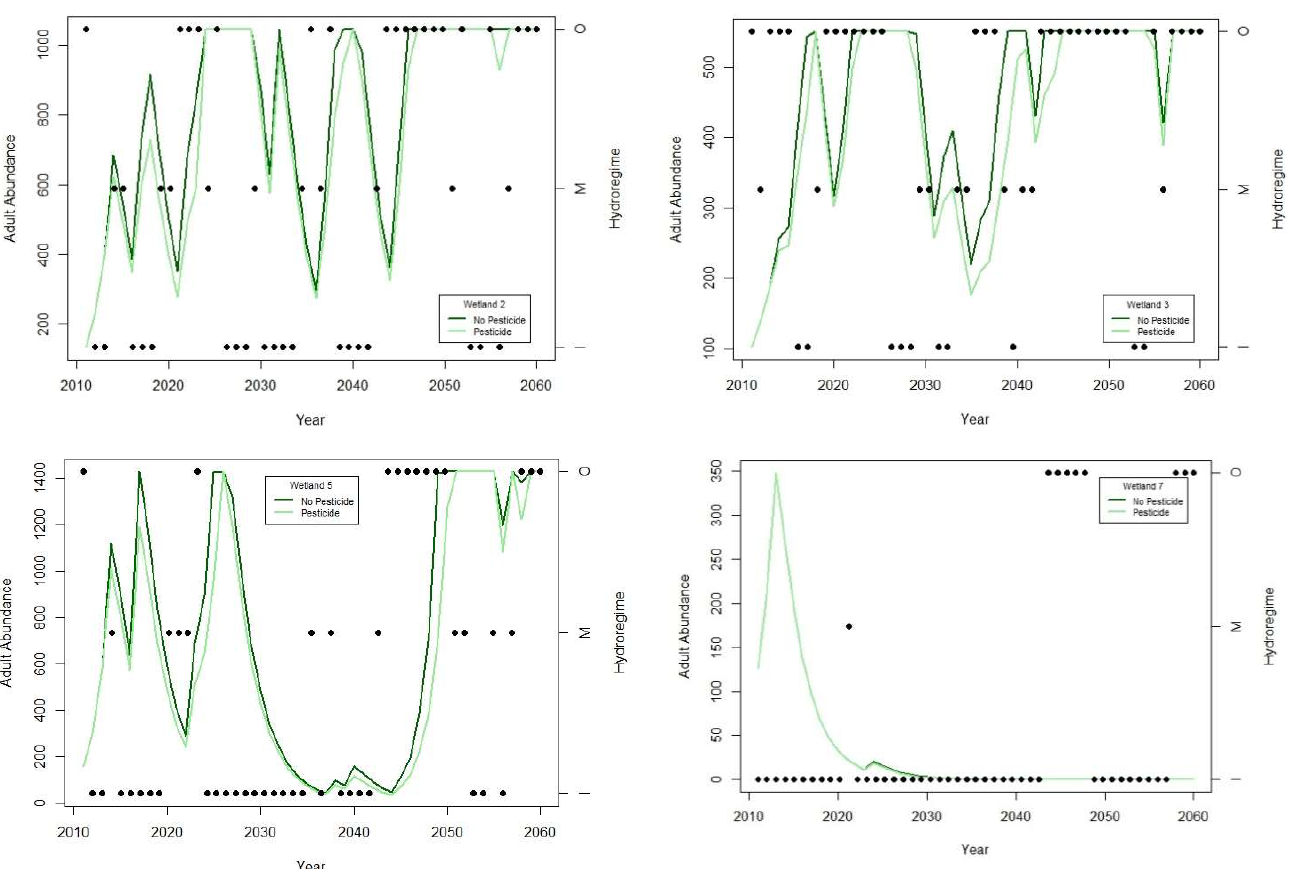
Figure 2. Estimated relative abundance of adults in southern toad populations, with standardized representative assumptions of density-dependent population limitation, for four patterns of hydroregime projections based on CSIRO Mk3.5 GCM climate projections at wetlands 2, 3, 5, and 7 (dark green). Population simulations varied fecundity based on hydroregime suitability of each year (OHY—points in upper plot, MHY—points in center plot, or IHY—points in lower plot) and reduced larval survival to represent aquatic exposure to carbaryl (light green).